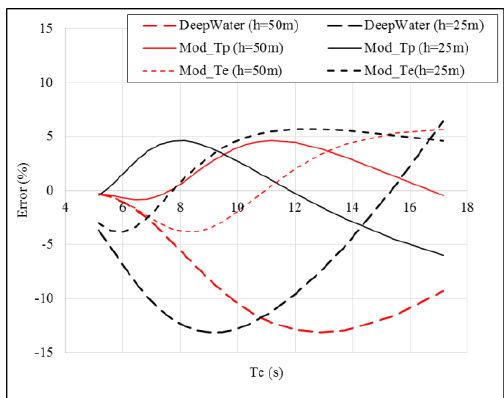
Figure 10. Errors at different water depths (50 m vs. 25 m).